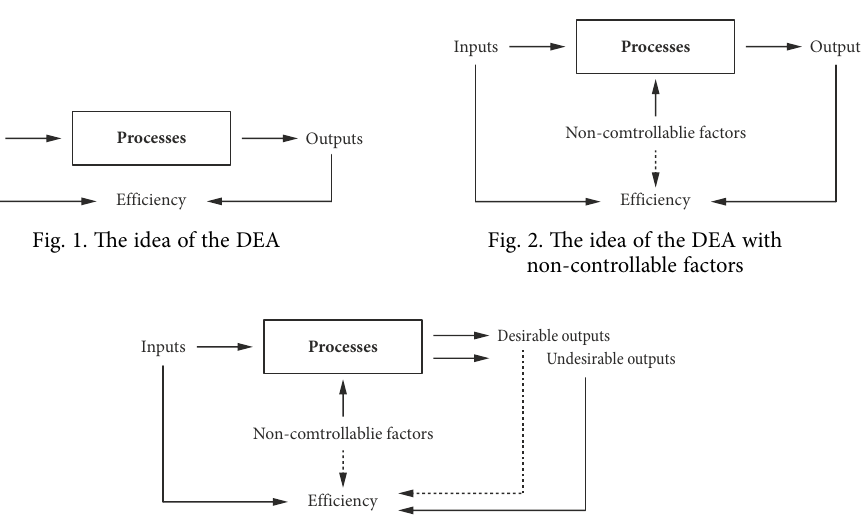
Fig. 3. The idea of the DEA with non-controllable factors and undesirable